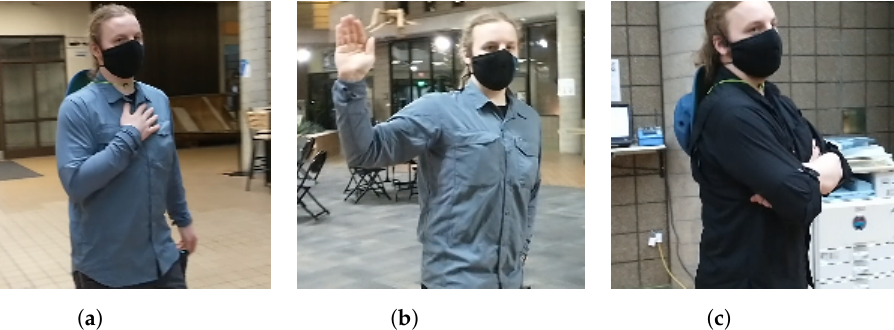
Figure 2. Each of the three poses depicted by author J. Schulte. ( a ) Command to follow the user and label them as the target. ( b ) Command to stop following the user. ( c ) No Command: follow previous